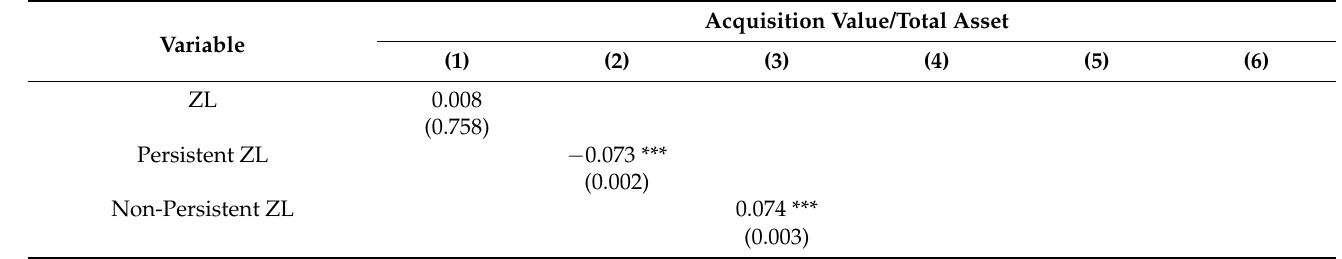
Table 5. The effect of leverage deviation on the relative deal size. This table presents results of tobit regressions examining the effect of ZL, persistent ZL, non-persistent ZL, under-leveraged, over-leveraged, and leverage deviation on the relative acquisition deal size. The dependent variable in the columns is the ratio of acquisition value over total assets. The dependent variable of tobit model is censored at 0. All variables are defined in Appendix A. The average marginal effects of tobit regressions are reported. Each regression includes year dummies. The p -values reported in parenthesis are based on standard errors clustered by 3-digit SIC industry. The symbol *** denotes statistical significance at the